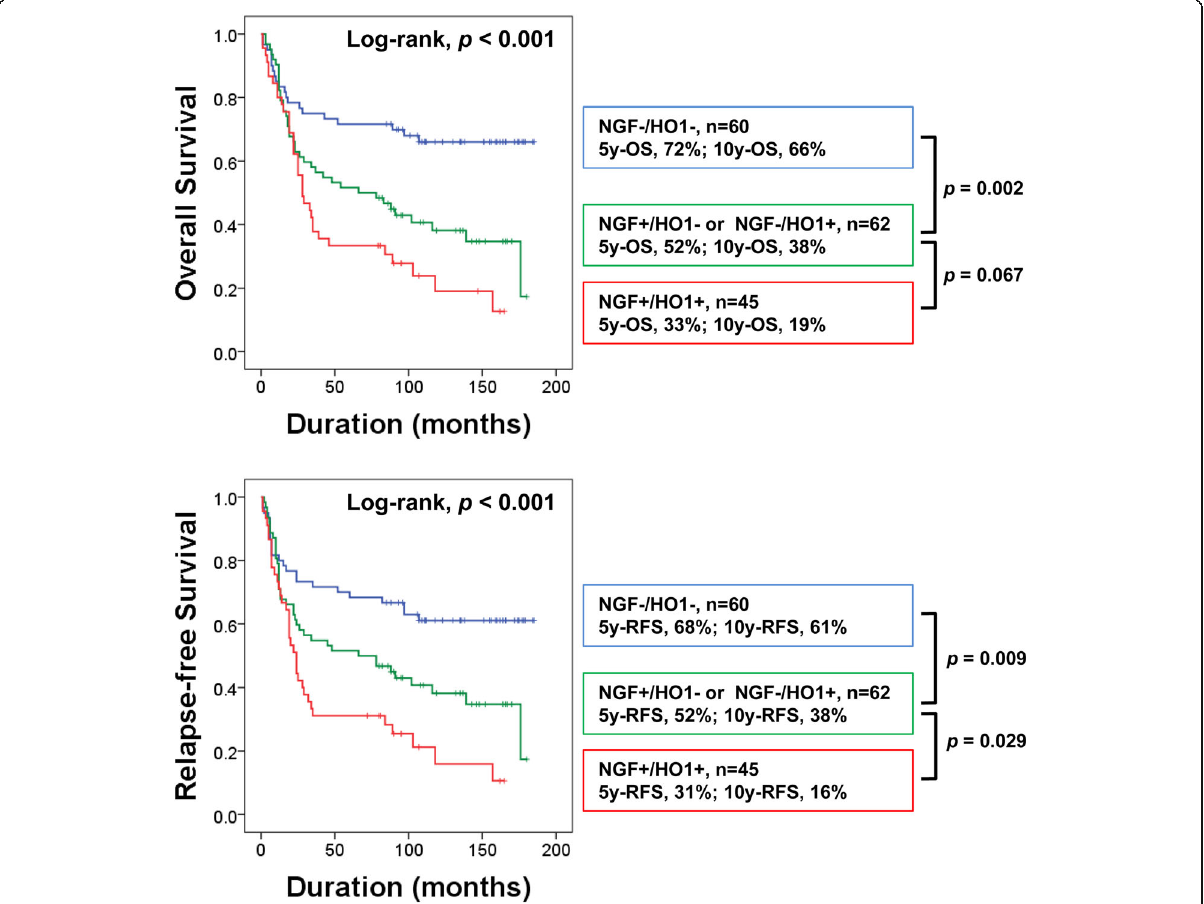
Fig. 4 Kaplan-Meier survival analysis according to co-expression patterns of NGF and HO1 in 167 gastric carcinomas. Gastric carcinomas were grouped into three sub-groups according to the co-expression pattern of NGF and HO1. NGF − /HO1 − , NGF-negative and HO1-negative. NGF − /HO1 − , NGF-negative and HO1-negative. NGF + /HO1 − , NGF-positive and HO1-negative. NGF − /HO1 + , NGF-negative and HO1-positive. NGF + /HO1 + , NGF-positive and HO1-positive. 5y-OS, overall survival rate at five-years. 10y-OS, overall survival rate at ten-years. 5y-RFS, relapse-free survival rate at five-years. 10y-RFS, relapse-free survival rate at